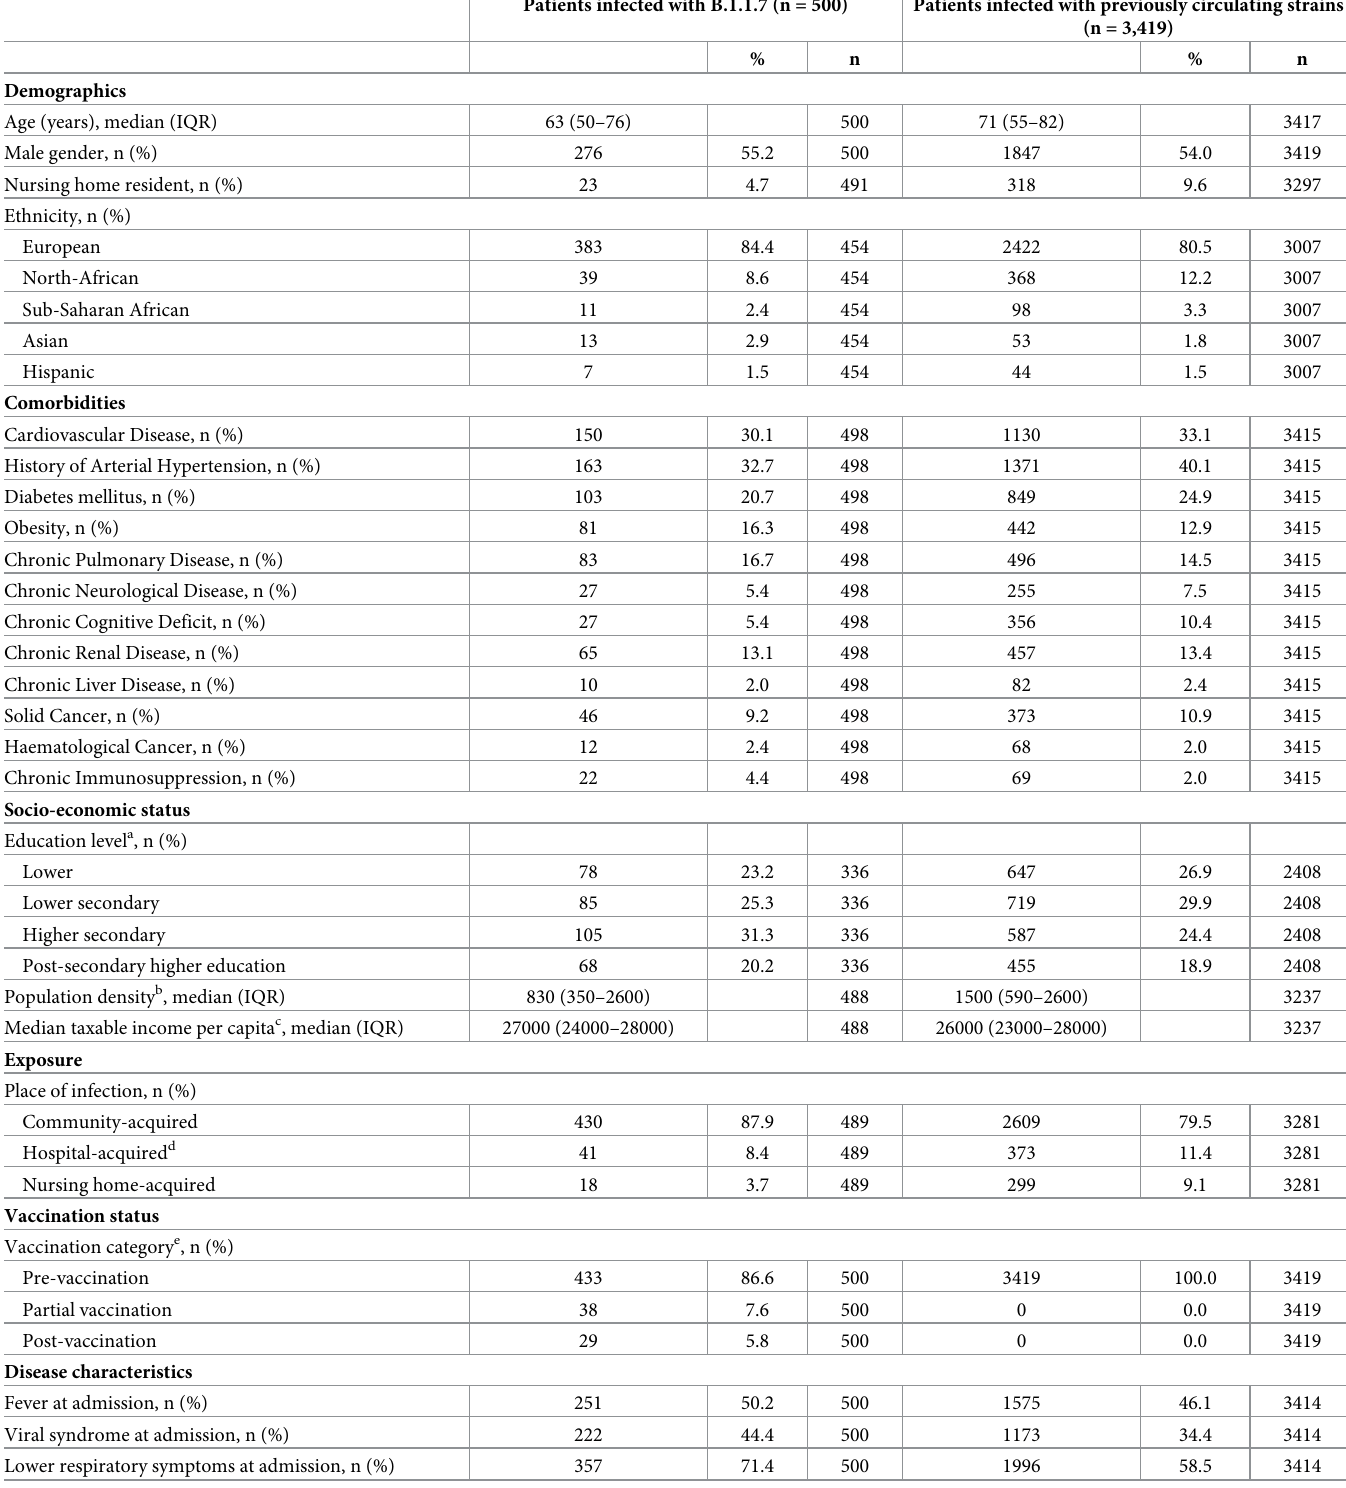
Table 1. Baseline characteristics per exposure status within a multi-center matched cohort study to assess the impact of SARS-CoV-2 variants on COVID-19 disease severity among hospitalized patients in